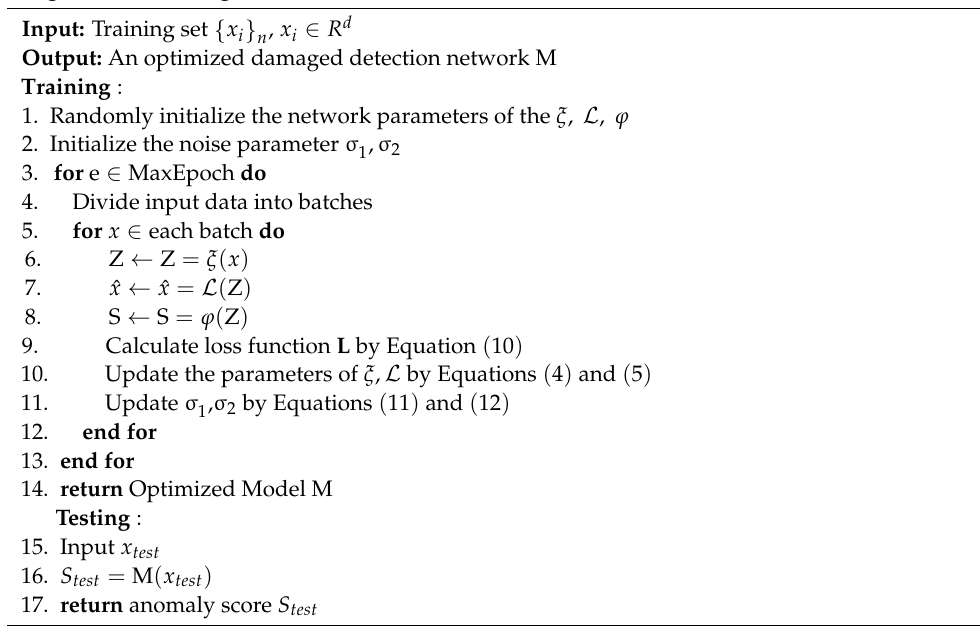
Algorithm 1. Damage Detection Network